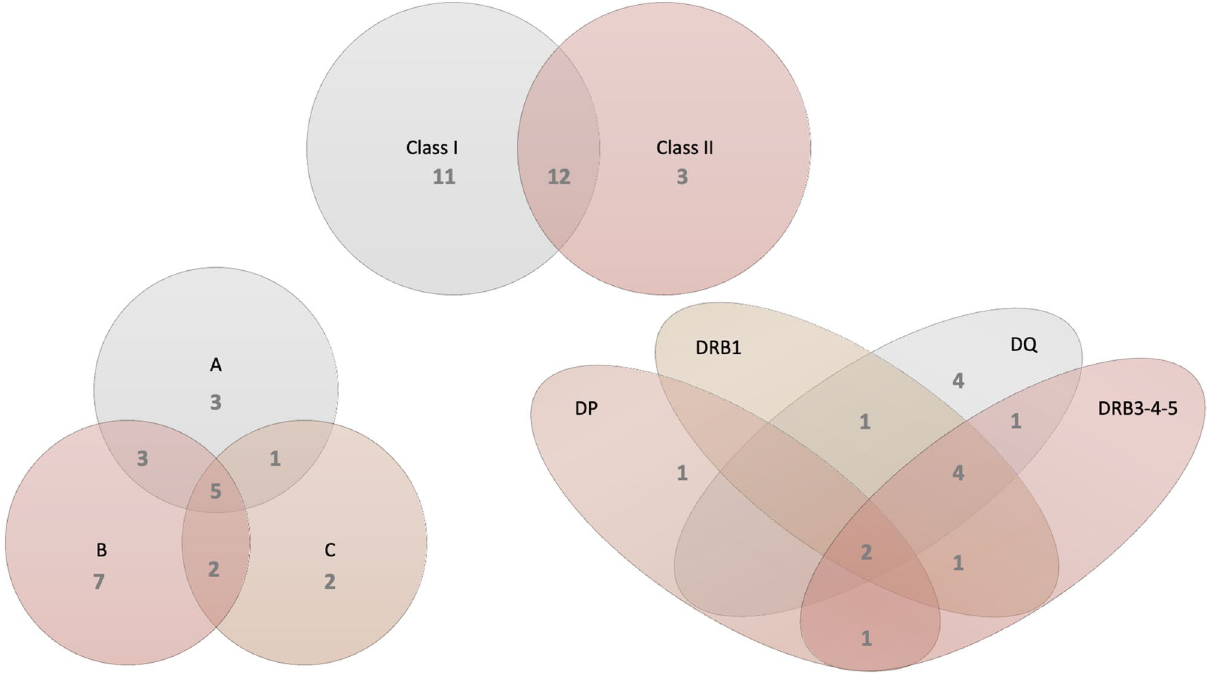
Figure 4. Specificity of anti-HLA antibodies. Anti-HLA antibodies, including HLA-A, B, C, DP, DQ, and DR, were detected in sera of 32 women with RPL. Specificity and number of individuals that were positive for anti- HLA antibodies are indicated in a Venn diagram